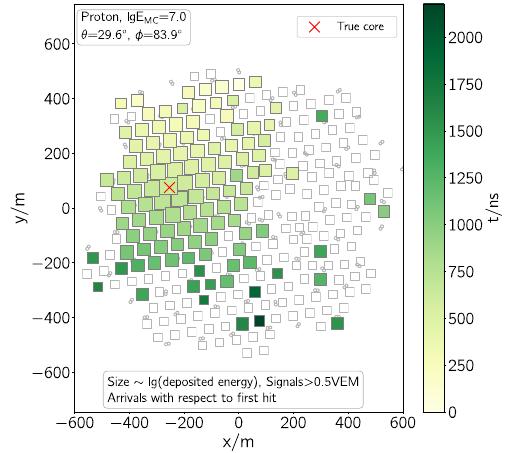
Figure 6. Layout of the scintillator array used in the simulations. The layout is overlayed with the detector response to an individ- ual shower, where the size of the squares denote the amplitude and the color the relative detection time.